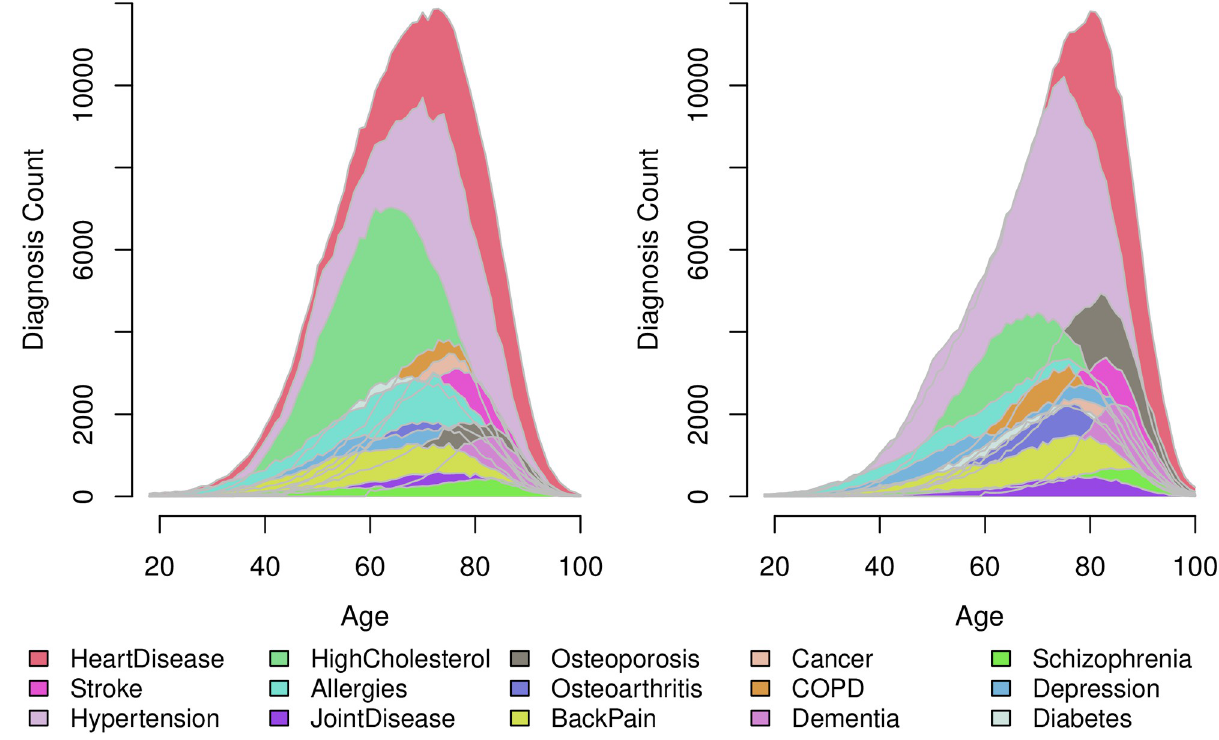
Fig 2. Diagnosis counts by age for the population of Danish chronic heart disease diagnosed individuals in the period 1995–2015. The figure shows males (left) and females (right). A diagnosis is counted when the individual obtains the algorithmic chronic disease diagnosis. The diagnoses are ordered, so diagnoses with larger variance in counts are on